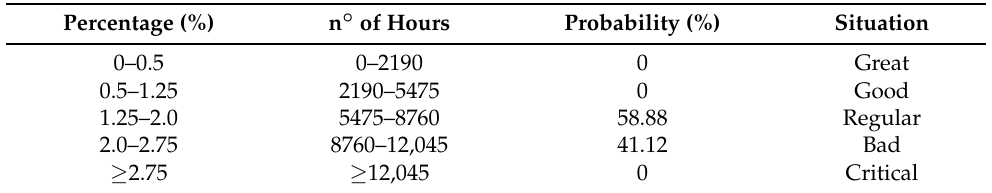
Table 2. Probability of Occurrence by HSS Interval—Simulation I.